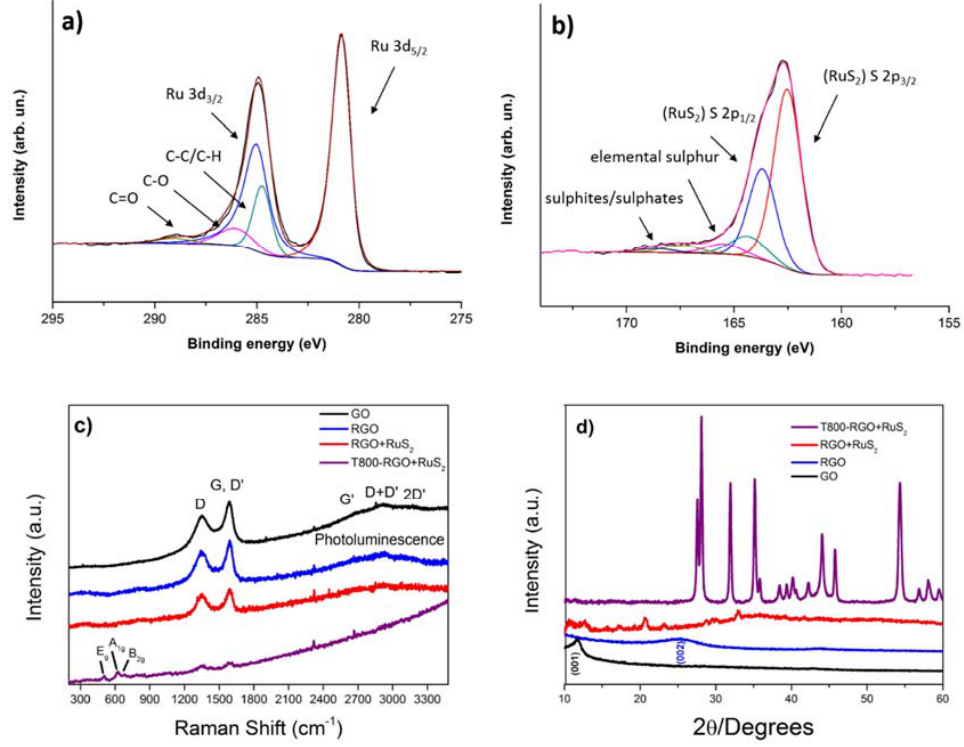
Figure 2. XPS High resolution scans of ( a ) C1s/Ru3d and ( b ) S2p regions of RGO aerogel decorated with Ruthenium active species containing RuS 2 nanoparticles; ( c ) Raman spectra of pristine GO, RGO, RGO/Ruthenium active species (before and after thermal annealing in inert gas) aerogels; ( d ) XRD of pristine GO, RGO and as ‐ synthesized RGO/RuS 2 (before and after thermal annealing in inert gas).